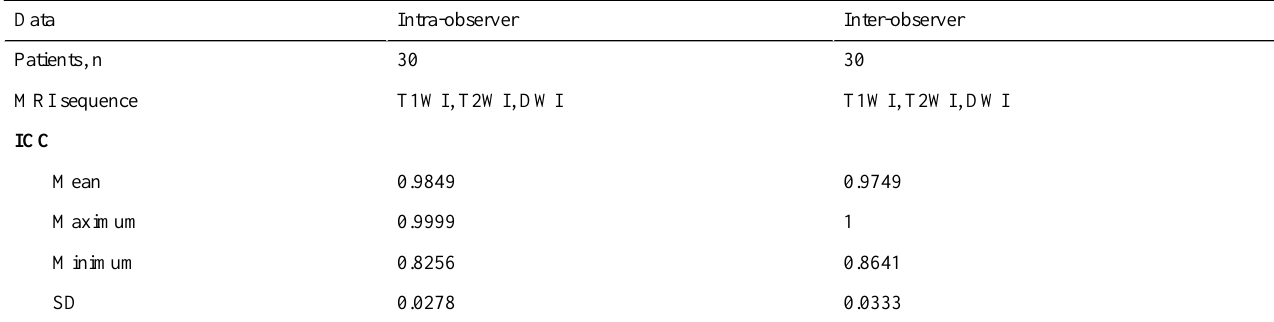
Table 3. The intraclass correlation coefficient (ICC) between the intra-observer and inter-observer. Inter-observerIntra-observerData 3030Patients,